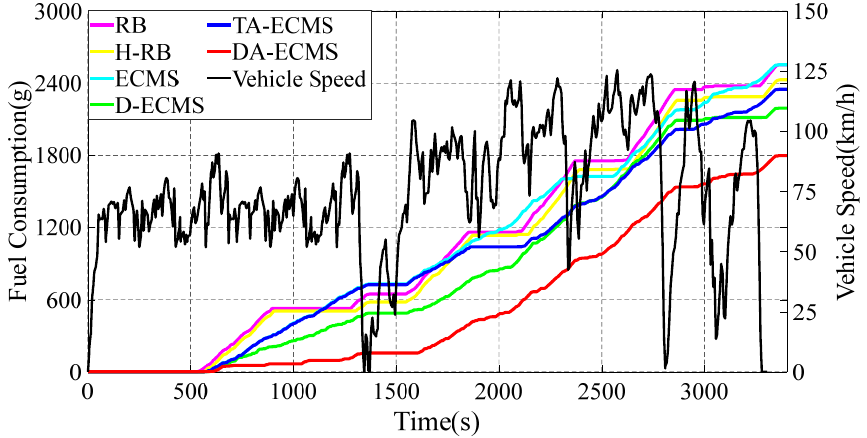
Figure 13. Variation curves for the vehicle speed and the fuel consumption under different strate- gies.